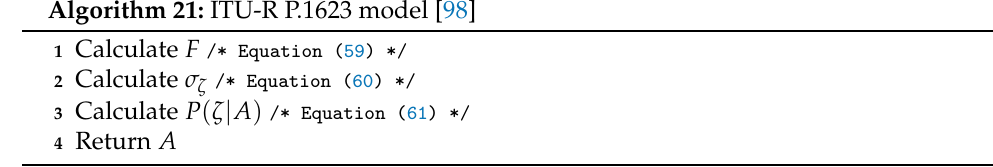
Algorithm 21: ITU-R P.1623 model